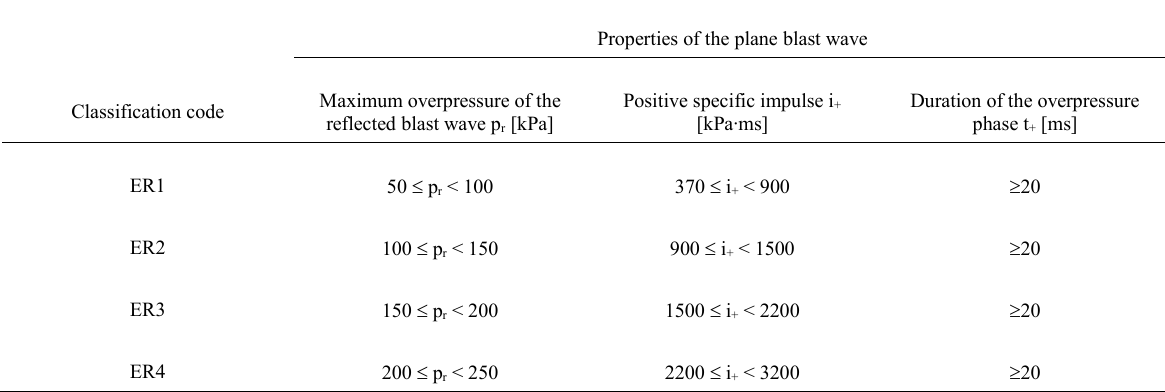
Table 1: Pressure wave parameters and classification according to DIN EN 13541